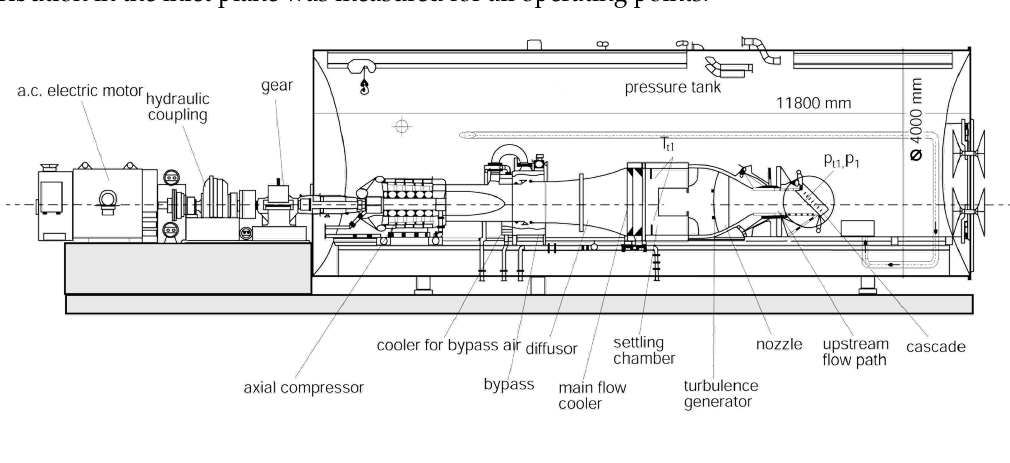
Figure 1. High Speed Cascade Wind